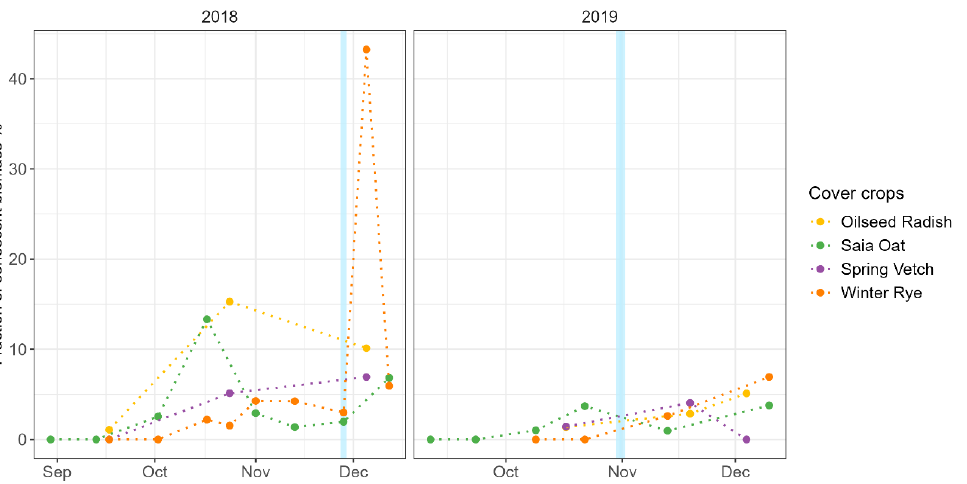
Figure 4. Fraction of senescent biomass (%) in total sampled biomass during the vegetation periods of cover crops in 2018 and 2019. Blue vertical lines highlight frost events (28 November 2018, 31 October 2019, 1 November 2019).